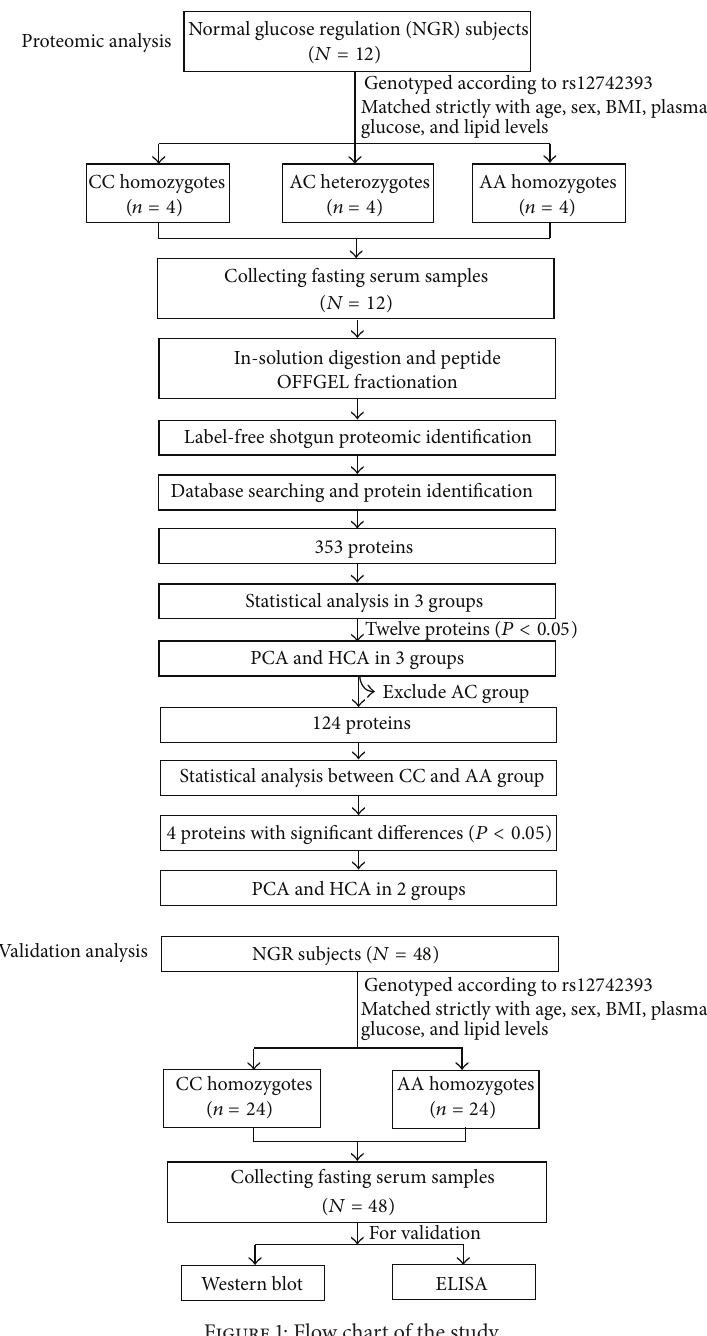
Figure 1: Flow chart of the